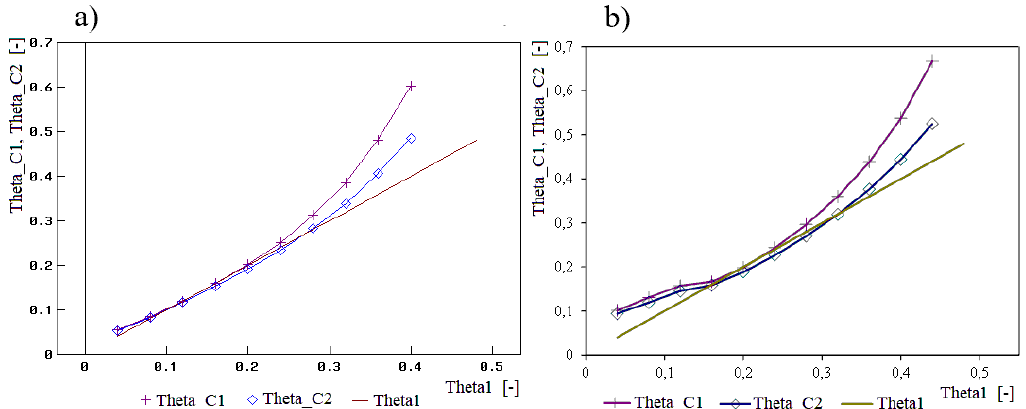
Figure 10: Values of diagnostic parameters ϑ C 1 (Theta_C1) and ϑ C 2 (Theta_C2) as functions of the dimensionless coeflcient of damping in the suspension system ϑ 1 (Theta1), obtained from an analysis of the factor of gain in the vertical force at the tire-exciter contact point (relative to the input force) close to the second natural frequency of the rear “quarter car”: a) results for the linear model; b) results for the nonlinear model